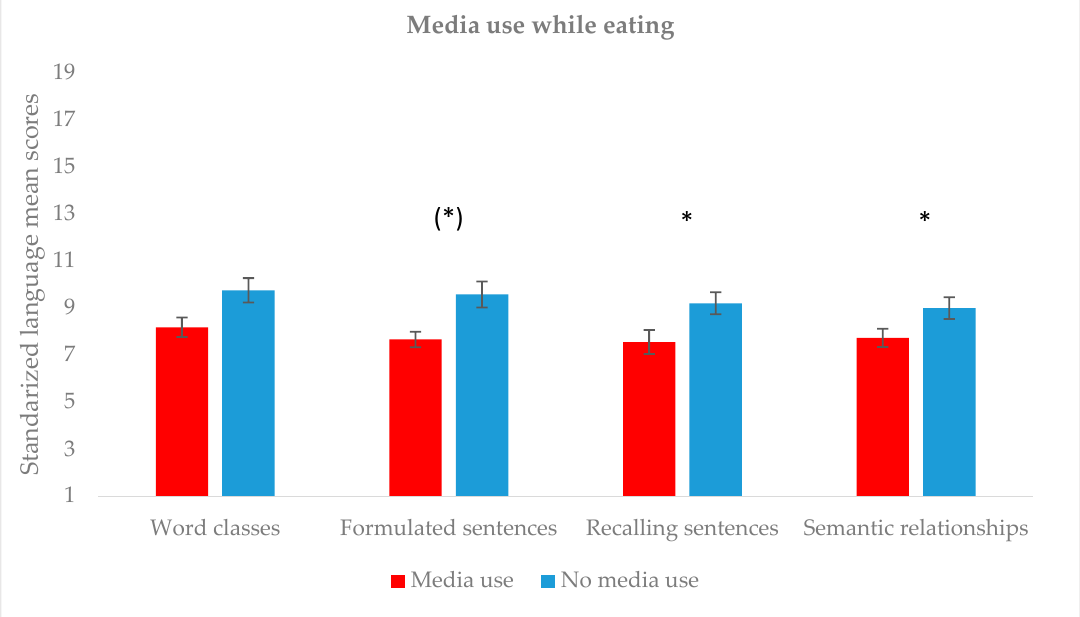
Figure 2. Mean scores on language tasks and use of technological devices while eating. * p < 0.05; (*) p < 0.06.